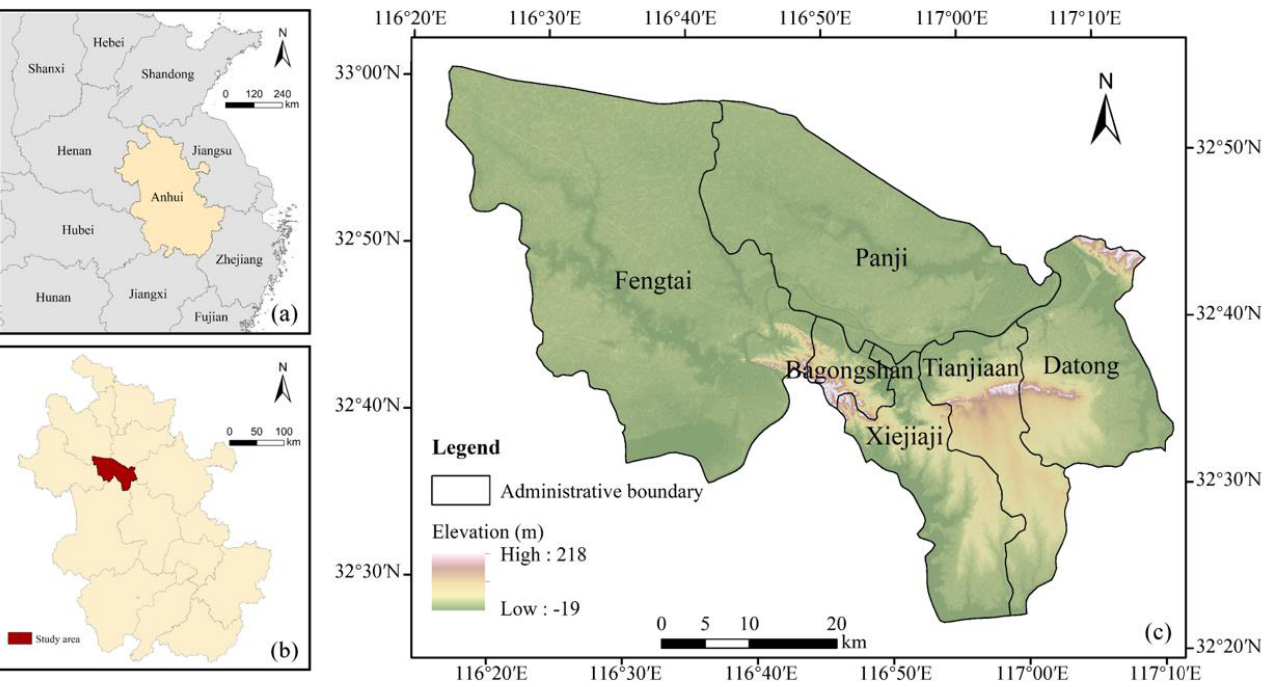
Figure 1. Study area: ( a ) The location of Anhui Province in the eastern part of China. ( b ) The location of Huainan City in Anhui Province. ( c ) The topography and administrative boundary of Huainan City.